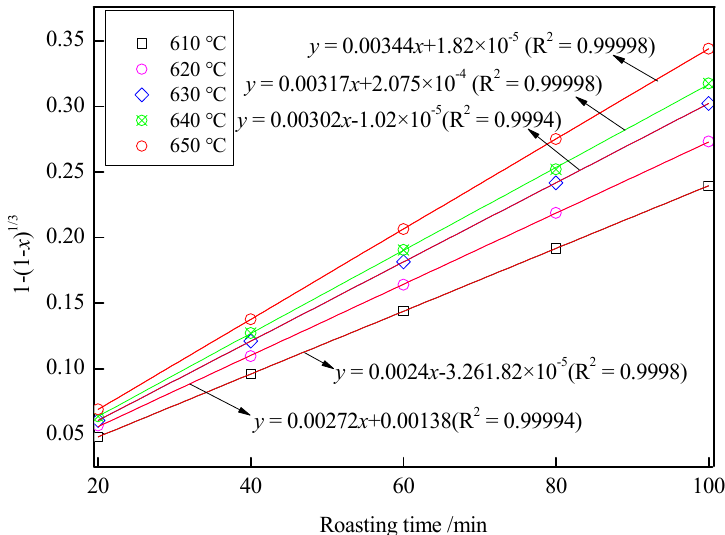
Figure 11. The relationship between the roasting time and 1 – (1 − x ) 1/3 .